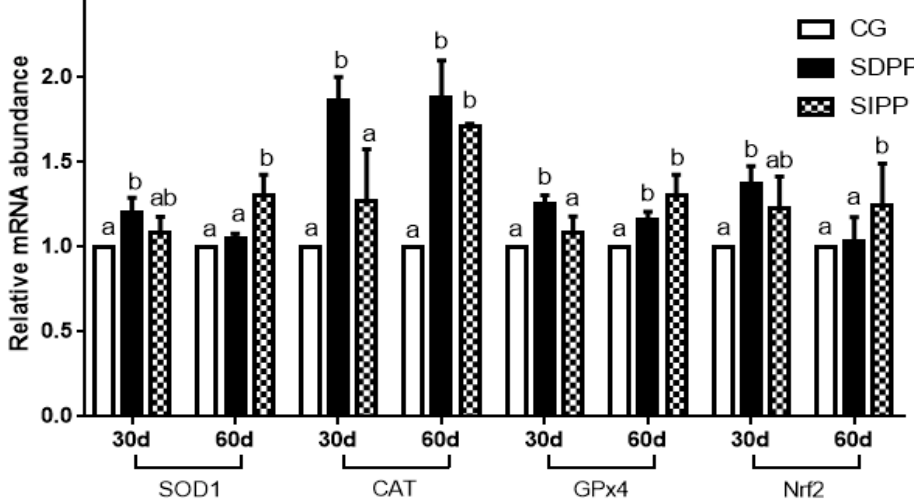
Figure 2. Effect of photoperiod change on relative gene expression of SOD1 , CAT , GPx4 and Nrf2 . Bars carrying different letters (a, b) were significantly different ( p < 0.05) (mean ± standard error, n = 6); CG: control group; SDPP: short-day photoperiod; SIPP: shortening-day photoperiod.